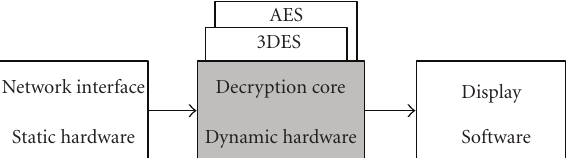
Figure 2: Set of mutually exclusive